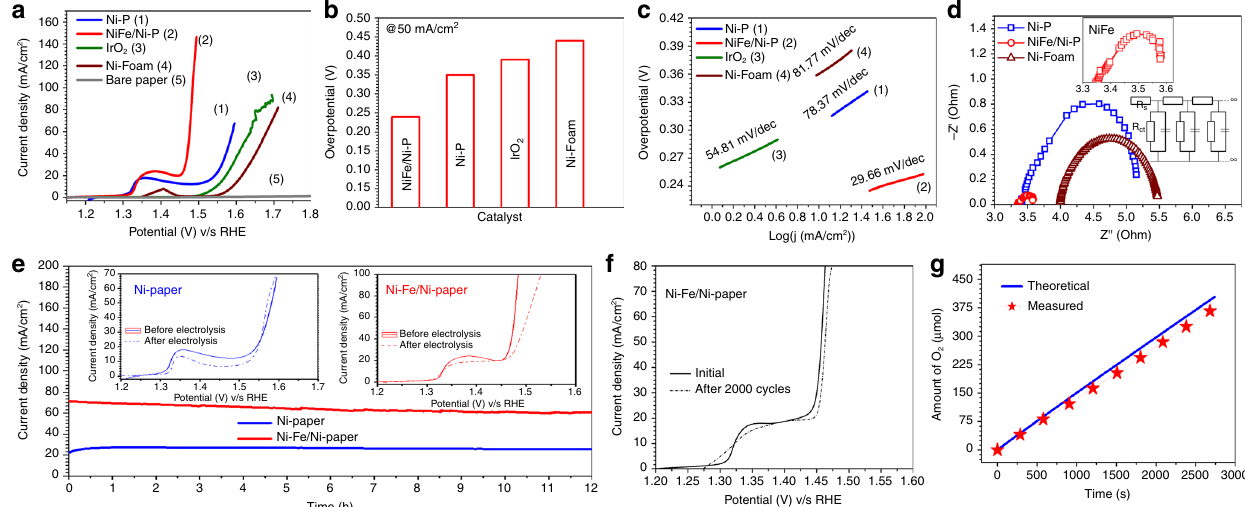
Fig. 5 Electrochemical performance of NiFe/Ni-P electrode towards OER. a OER polarization curves (iR-corrected) with a scan rate of 10 mV s − 1 in 1 M KOH, b the potentials required to reach 50 mA cm − 2 , c corresponding Tafel plots and d EIS spectra under a dc bias of 1.6 V. Insets show the Nyquist plot of NiFe/Ni-P and the equivalent transmission line model circuit used for fi tting. e Chronoamperometric stability test of NiFe/Ni-P and Ni-P for 12 h at 1.5 V (without iR-correction). Insets show steady state LSV plots before and after 12 h. f LSV scan of NiFe/Ni-P electrode before and after 2000 CV cycles showing a negligible increase of η 50 by 0.48%. g Faradic ef fi ciency measurement of NiFe/Ni-P showing the theoretically calculated and experimentally measured O 2 gas with